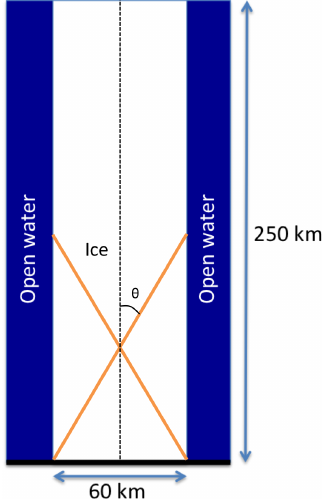
Figure 2. Idealized domain for uniaxial compression simulations, with a solid boundary (Dirichlet conditions, u = v = 0) at the bot- tom and open boundaries (Neumann conditions, ∂u/∂n = 0) on the sides and top. The initial conditions are h = 1m and A = 100% in a region of 250km × 60km in the center of the domain (white), with two 20km wide bands of open water on each side (blue). The ori- entation of the LKFs ( θ ) is defined as half of the angle between conjugate pairs of fracture lines (orange